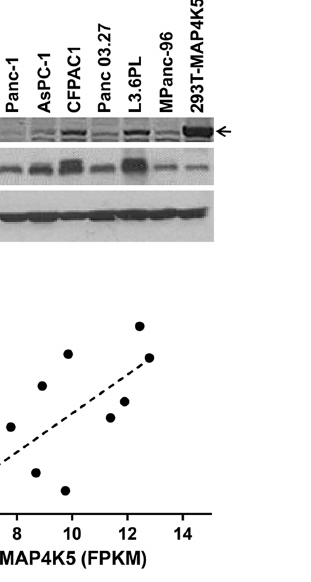
Fig 4. A. Immunoblotting for MAP4K5 and E-cadherin expression in HPDE cells, immortalized human pancreatic ductal cells, and pancreatic cancer cell lines. The 293T cells transfected with MAP4K5 cDNA construct saved as a positive control for immunoblotting. B. Pearson ’ s correlation analysis between the MAP4K5 mRNA and CDH1 mRNA expression by RNA-sequencing analysis in 11 pancreatic cancer cell lines.